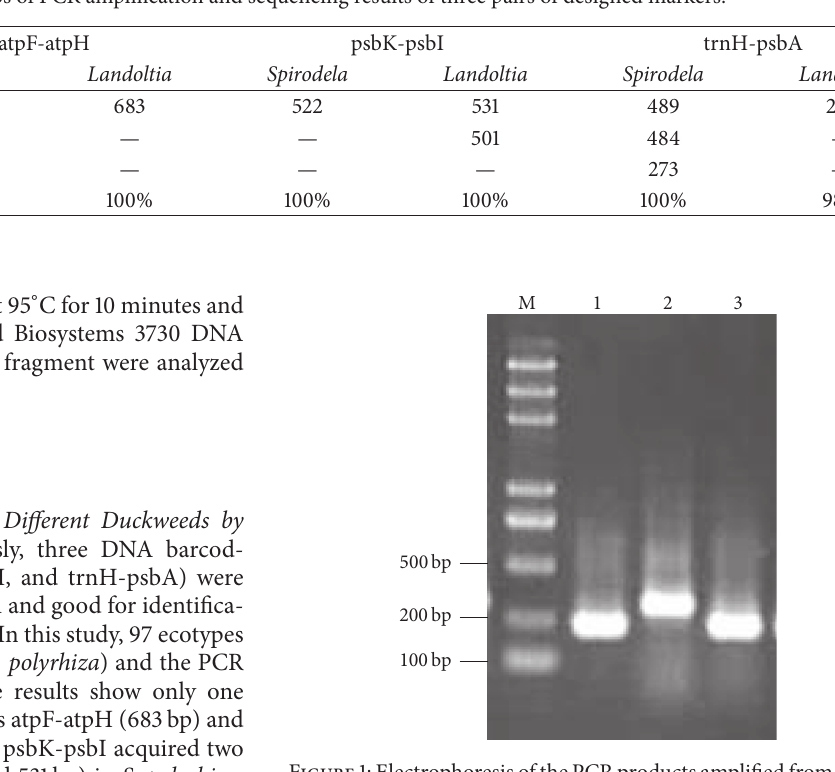
Figure 1: Electrophoresis of the PCR products amplified from duck- weed ( Landoltia punctata ecotype ZH0001-S-0) with the designed three pairs of primers in an agarose gel. M: DNA ladder Marker III (100, 200, 500, 750, 1,000, 2,000, 3,000, and 5,000 bp; Tiangen Biotech Co., Ltd.). Line 1: primers SC19/20. Line 2: primers SC35/36. Line 3: primers